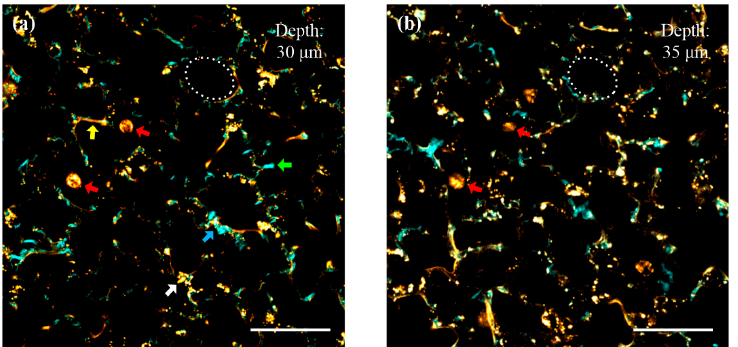
Figure 4. Simultaneously acquired multiphoton images of mouse pulmonary alveoli at di ff erent depths, 2 µ s / pixel, 512 × 512 pixels. ( a ) A pseudo-colored two-photon fluorescence (TPF) and second-harmonic generation (SHG) image acquired at the depth of 30 µ m into the pulmonary parenchyma. Cyan pixels (obtained from CH1) are mainly derived from prominent SHG of collagen. The green arrow indicates a pronounced bundle of collagen fibers. Yellow pixels (obtained from CH2) are mainly derived from autofluorescence of elastin, macrophages, and surfactant proteins. The yellow arrow denotes notable elastin fibers. The white arrow indicates surfactant proteins gathered probably in the cytoplasm of a type II pneumocyte. The blue arrow shows that collagen fibers spiral around elastin fibers. ( b ) A pseudo-colored TPF and SHG image simultaneously acquired at the depth of 35 µ m into the pulmonary parenchyma. The red arrows in ( a , b ) denote the sections of the same macrophages at both depths. The scale bar is 40 µ